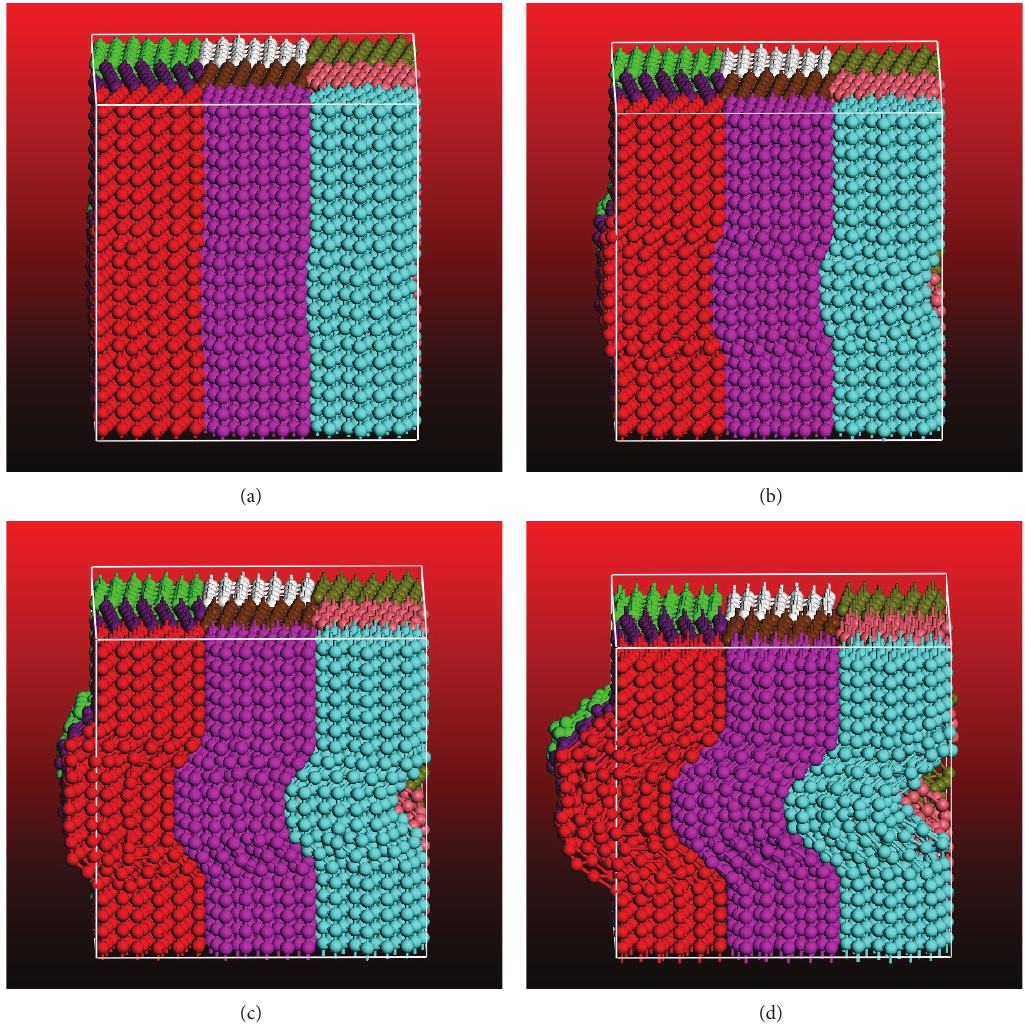
Figure 7: Coarse-grained microstructure, during axial compression, within the computational cell containing (initially) defect-free virgin PPTA fiber at the longitudinal stretch values of (a) 0.975; (b) 0.950; (c) 0.925; and (d)